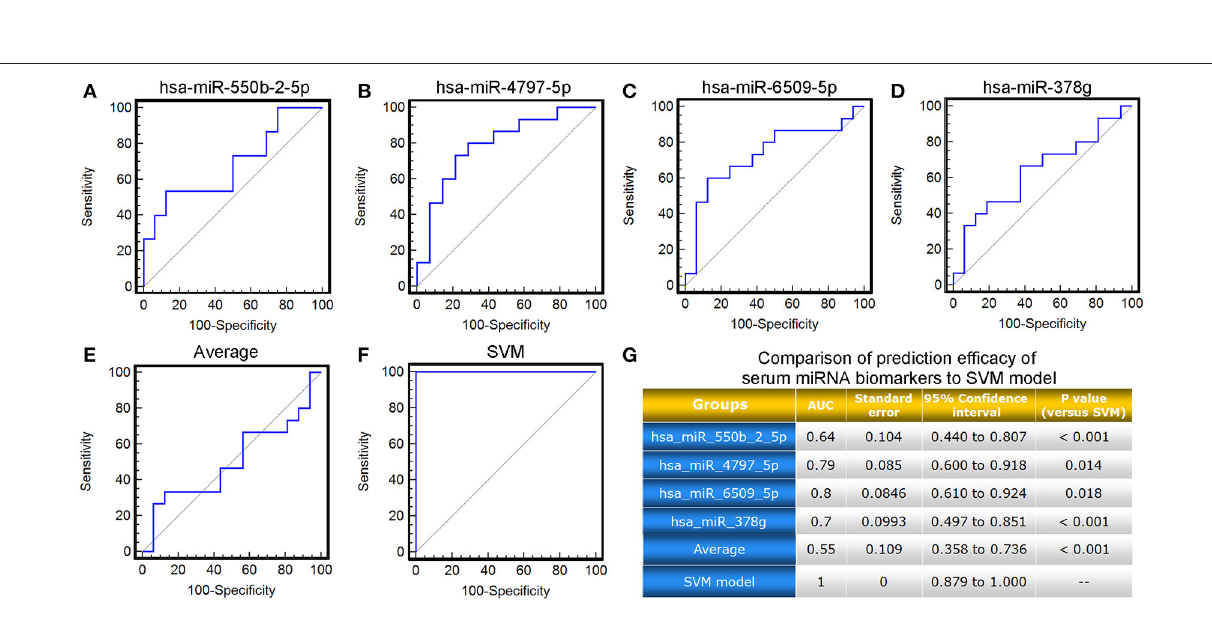
Frontiers in Pharmacology | www.frontiersin.org